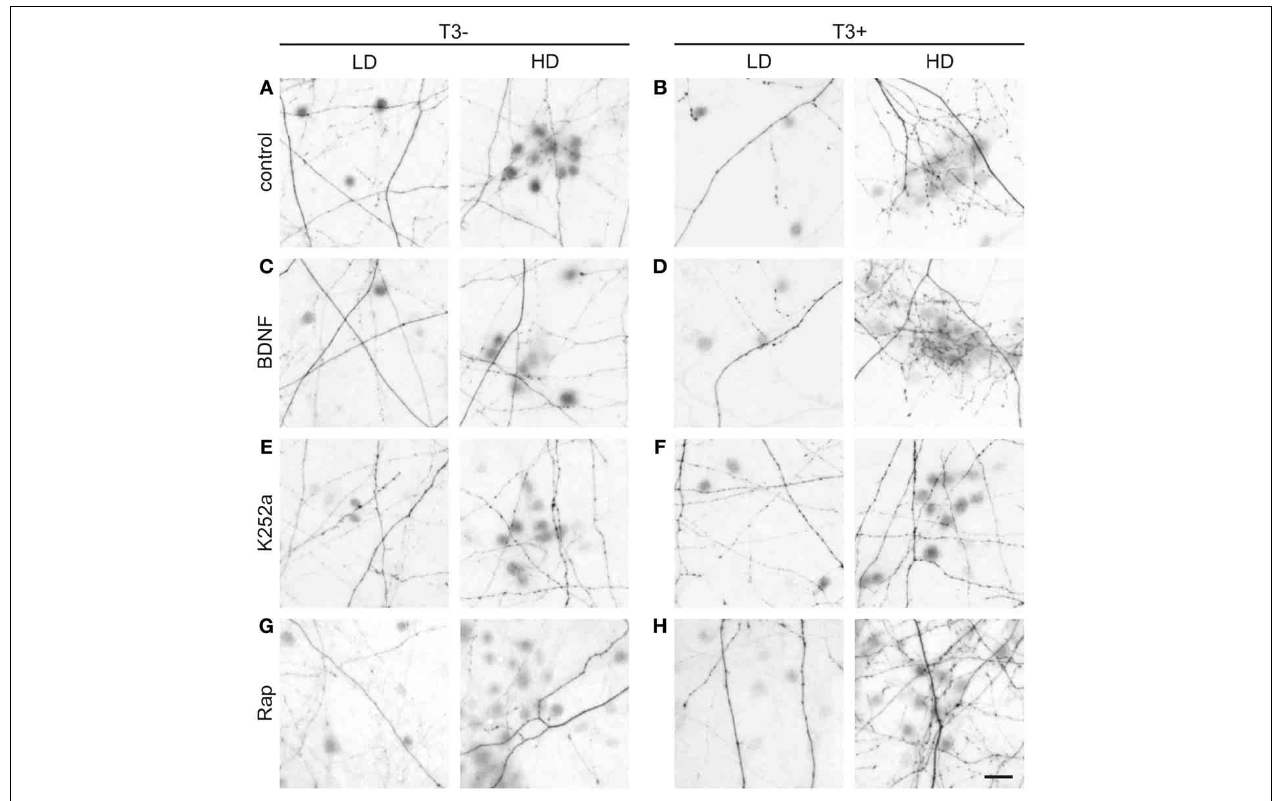
FIGURE 11 | T3-dependent distribution of L-GABA axons and boutons and the effect of trkB and mTOR signaling. Images show GABAergic innervation patterns of LD or HD areas in 14-day-old T3 − (A) and T3 + control